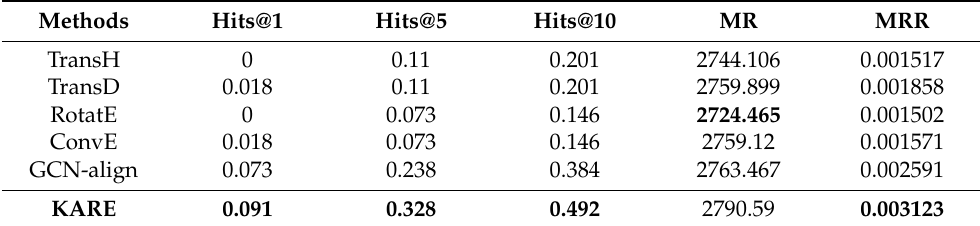
Table 2. Results of knowledge graph alignment with the full dataset with 5 metrics.